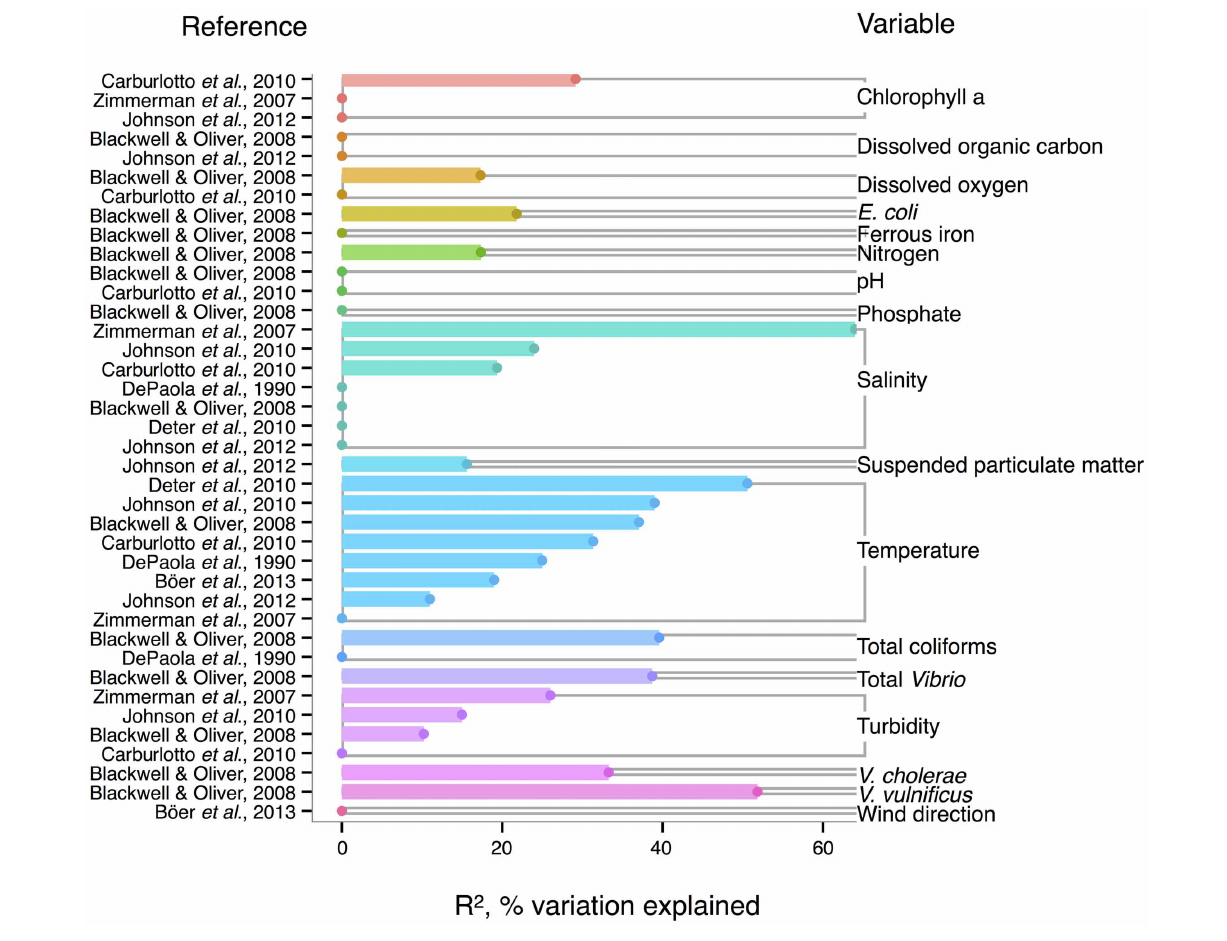
reference may conduct multiple analyses for a given variable (e.g., on subsets of data or considering different variables combinations for data regression). Dots indicate bar heights, and where a dot occurs without a bar, R 2 was non-significant (i.e., R 2 =